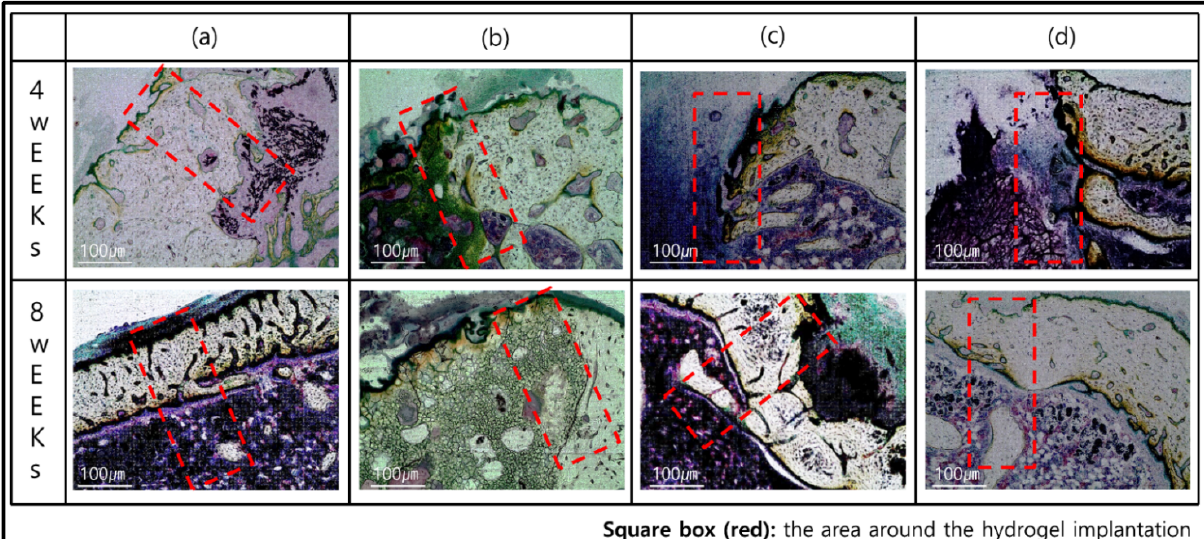
Figure 6. Histological images of Villanueva Osteochrome Staining for bone tissues after 4 and 8 weeks: ( a ) GelMA-S, ( b ) GelMA-D, ( c ) GelMA-ST100, and ( d ) GelMA-DT100 .